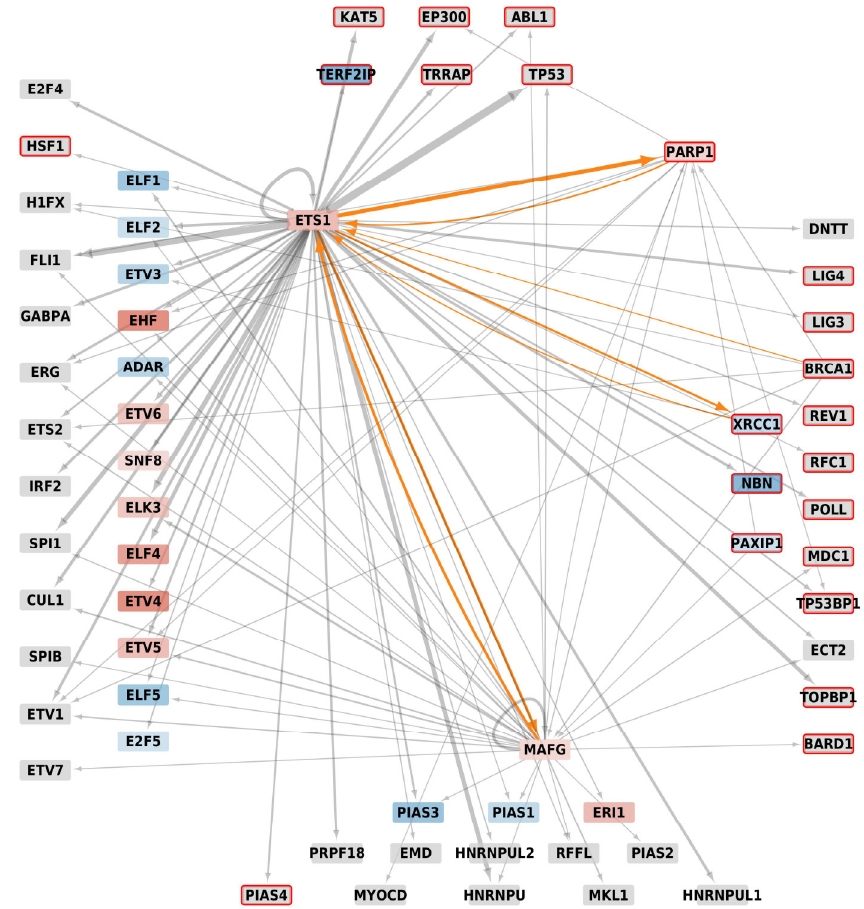
Figure 5. Metatargetome of Ets-1, PARP-1, BRCA1, PAXIP1, XRCC1 and MAFG filtered on the proteins of the network of Figure 4b. Differential expression data between MDA-MB-231 and MCF-7 cells were mapped onto the network; only signals with adjusted p -value ≤ 0.01 were kept; nodes are colored as a gradient of the log 2 fold-change from blue (log 2 (Fold Change) ≤ − 2) to white (log 2 (FC) = 0) and red (log 2 (FC) ≥ 2); grey nodes do not show significantly different signals; the width of arrows relates to the number of occurrences in databases found by iRegulon, the larger, the higher number; on the left stand the ETS homologs, at the bottom the SAP homologs, on the right the BRCT homologs and top shows the other proteins of the Figure 4b; proteins that are associated to DNA-repair have a red border; orange arrows are those that involve a regulation by Ets-1, eventually reciprocal.